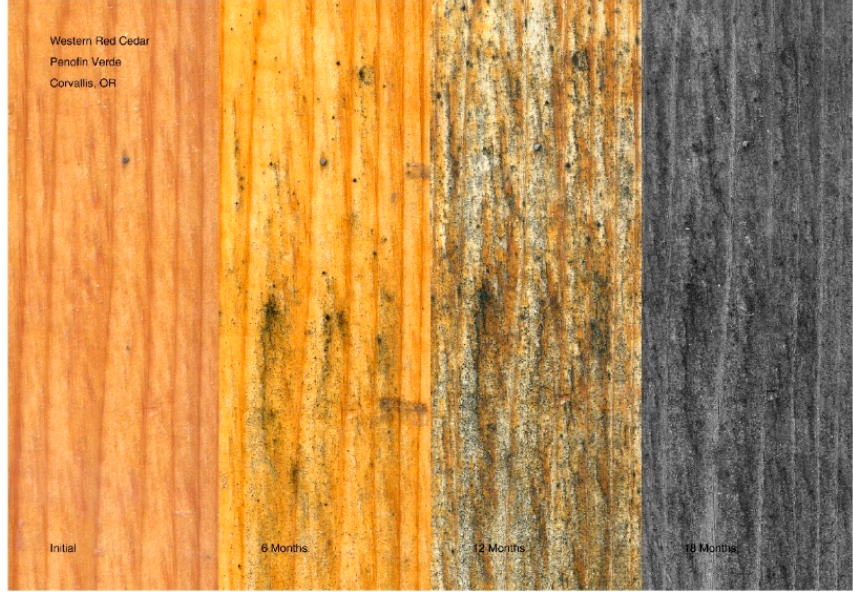
Figure 17. Example of the same western redcedar sample treated with Penofin Verde and exposed on a test fence near Corvallis, OR for 0, 6, 12, and 18 months (left to